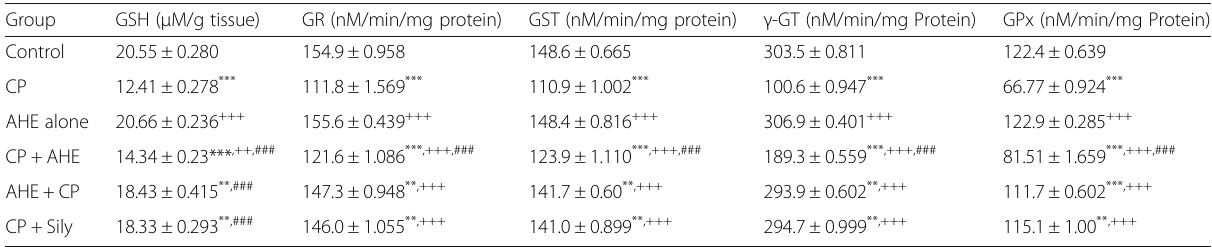
Table 4 Effect of cisplatin (CP) and different treatments of AHE on cardiac enzymatic antioxidant levels and GSH profile Group